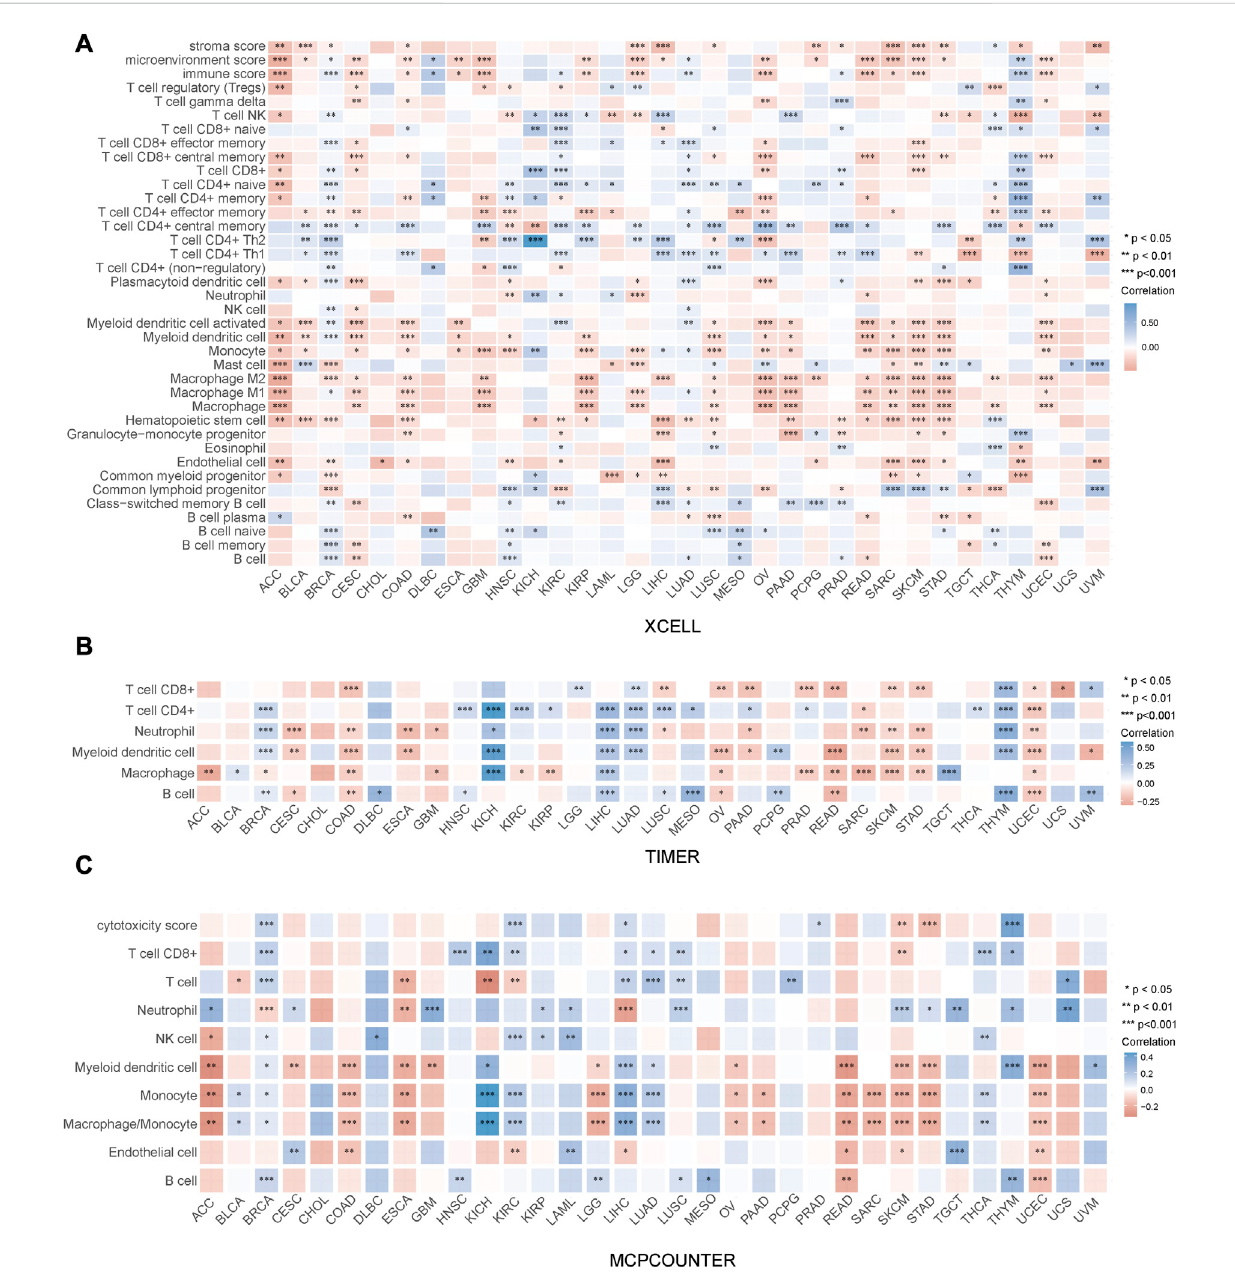
Correlation between PRR7-AS1 expression and immune cell in fi ltration. The expression of PRR7-AS1 was signi fi cantly correlated with various immune in fi ltrating cells based on the (A) XCELL, (B) TIMER and (C) MCPCOUNTER algorithm. Correlation was tested by Spearman methods. * p <